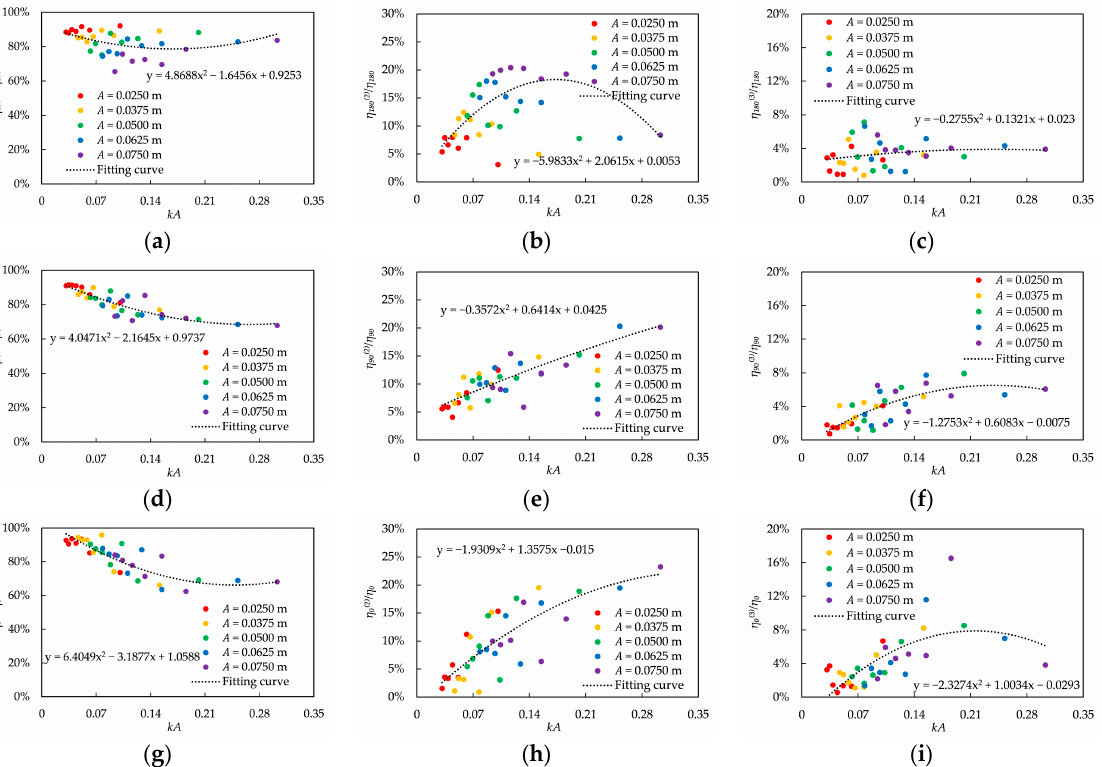
Figure 12. Variation of measured harmonics with the wave steepness kA : ( a ) linear component on front point, ( b ) second-harmonic component on front point, ( c ) third-harmonic component on front point, ( d ) linear component on shoulder point, ( e ) second-harmonic component on shoulder point, ( f ) third-harmonic component on shoulder point, ( g ) linear component on back point, ( h ) second- harmonic component on back point, and ( i ) third-harmonic on back